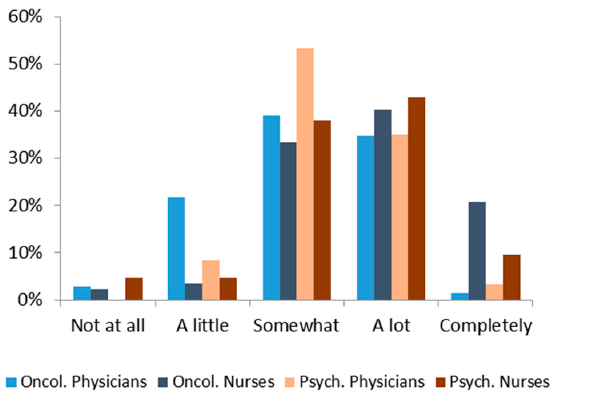
( B ) Figure 3. ( A ) Histograms of personal conditions for professionals. ( B ) Burden due to decisional con- flicts in different professional groups. When the “Burden due to Decisional Conflicts” question was analyzed, significantly higher values were seen in the nursing group compared to physicians ( p < 0.001), but there were no significant differences between oncology and psychiatry professionals ( p = 0.649). In a multivariate analysis of this item, oncology nurses suffered from a significantly higher burden than oncology ( p < 0.001) and psychiatry physicians ( p = 0.027) (Figure 3B).